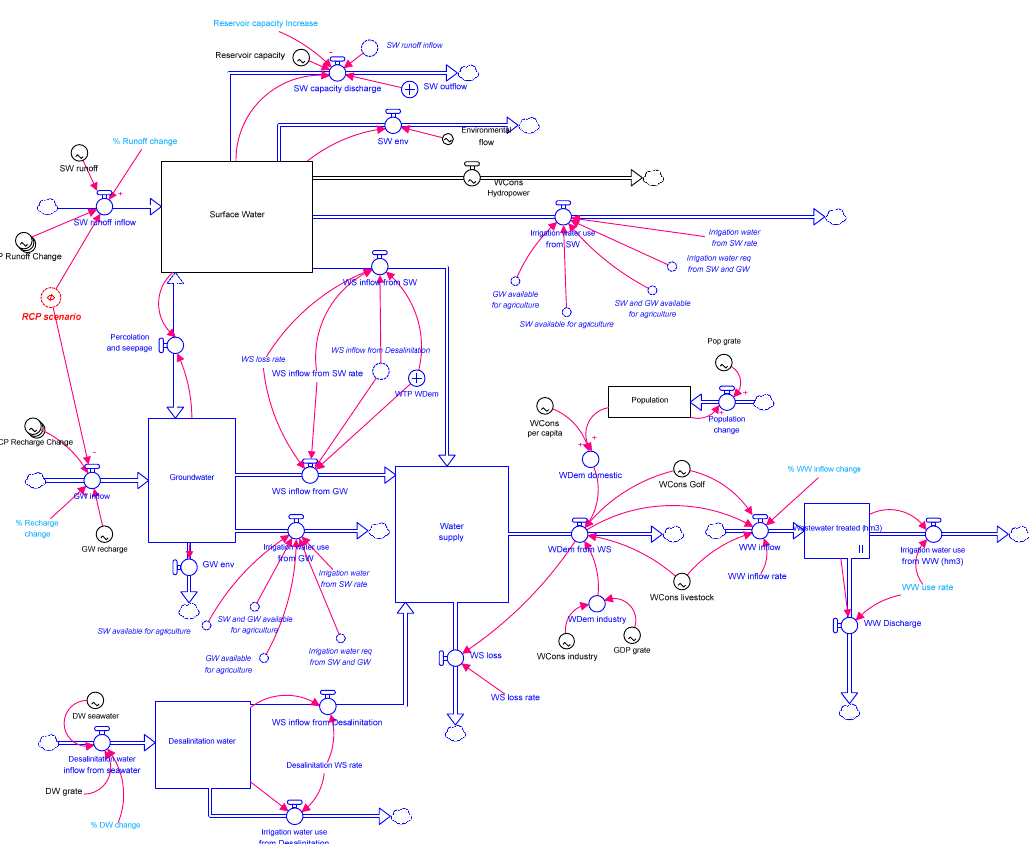
Figure 4. Water sector representation in the system dynamics model. Source: our own elaboration.